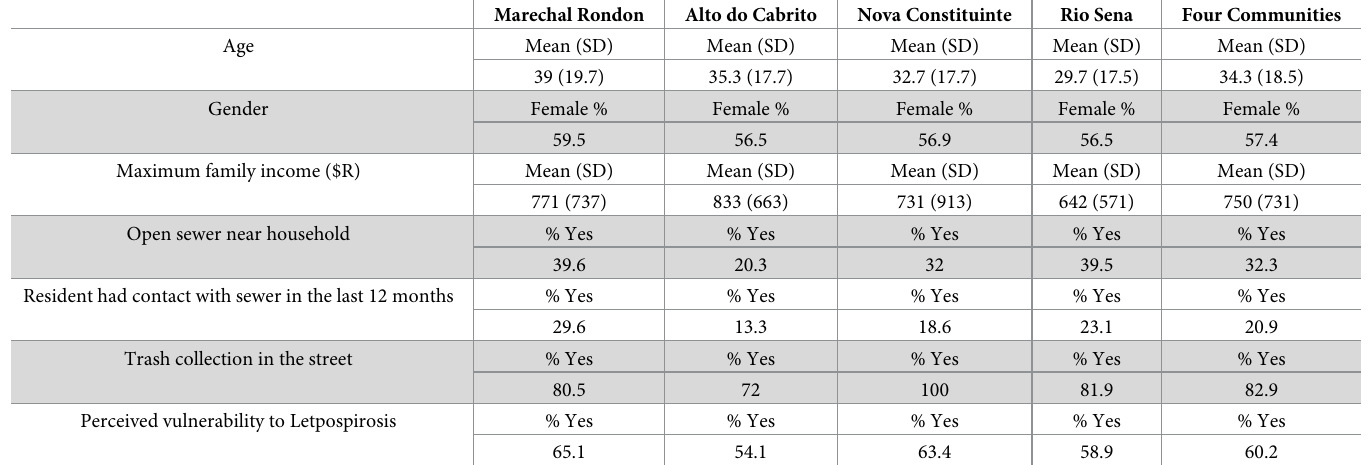
Table 1. Key variables measured in the four